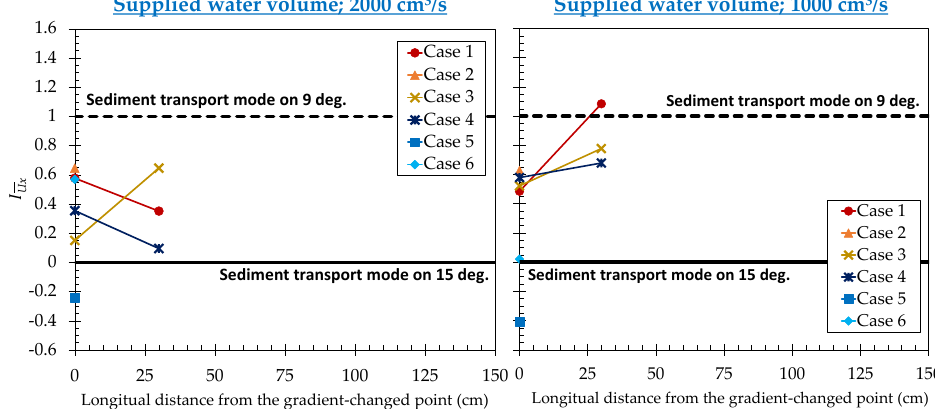
Figure 8. Transition indices of sediment transport modes based on averaged gravel migration velocities within the “median depth” in the interior of the “frontal part” of the debris flow, 𝐼 𝑈̅𝑥 , for all cases with two inflow rates.